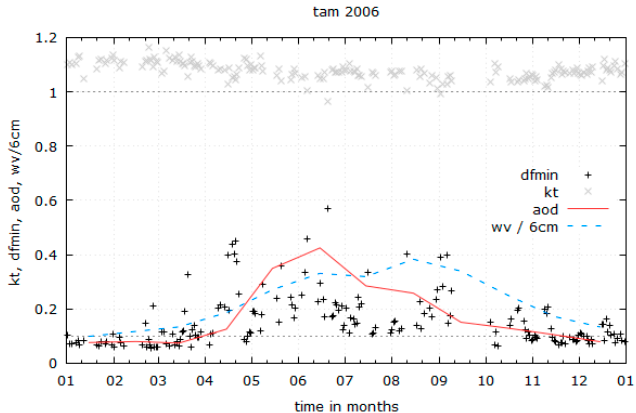
Figure 9. Variation of df min (black) of days with clear skies over a year in Tamanrasset, 2006. While df min is mostly close to 0.1 in wintertime, it varies strongly from spring to autumn, with no clear relation to the mean clearness index of the corresponding day (grey). It was found that changing levels of aerosols (red) and water vapour (dotted blue) may cause this effect.